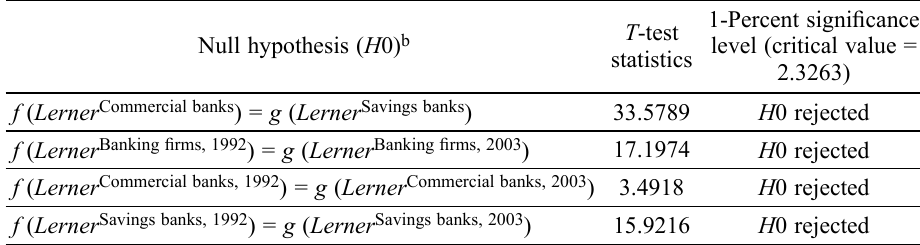
Table 2. Distribution hypothesis tests a ,